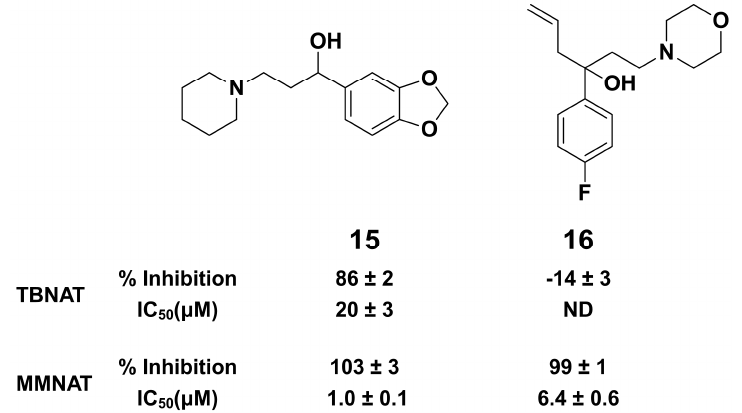
Figure 4. Active hits obtained by in silico 3D-shape